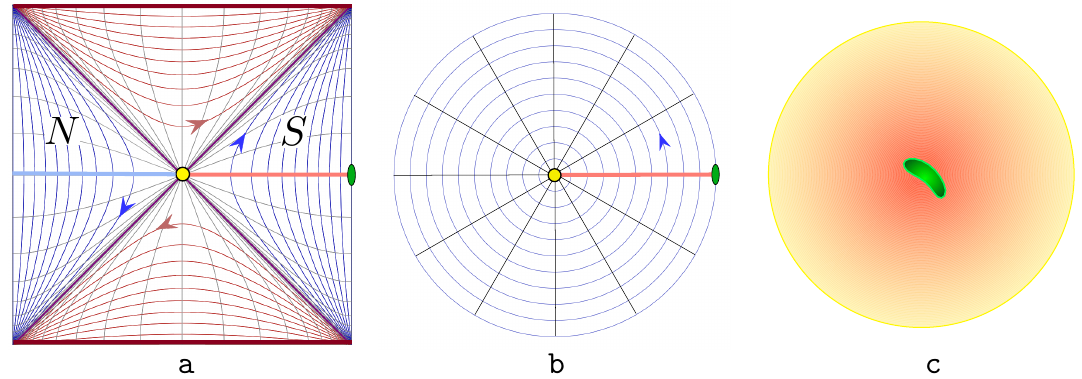
Figure 5 . a: Penrose diagram of global dS, showing flows of SO(1 , 1) generator H = M 0 ,d +1 , S = southern static patch. b: Wick-rotated S = sphere; Euclidean time = angle. c: Pelagibacter ubique inertial observer in dS with ‘ = 1 . 2 µ m finds itself immersed in gas of photons, gravitons and higher-spin particles at a pleasant 30 ◦ C . More details are provided in figure 14 and appendix D.3.